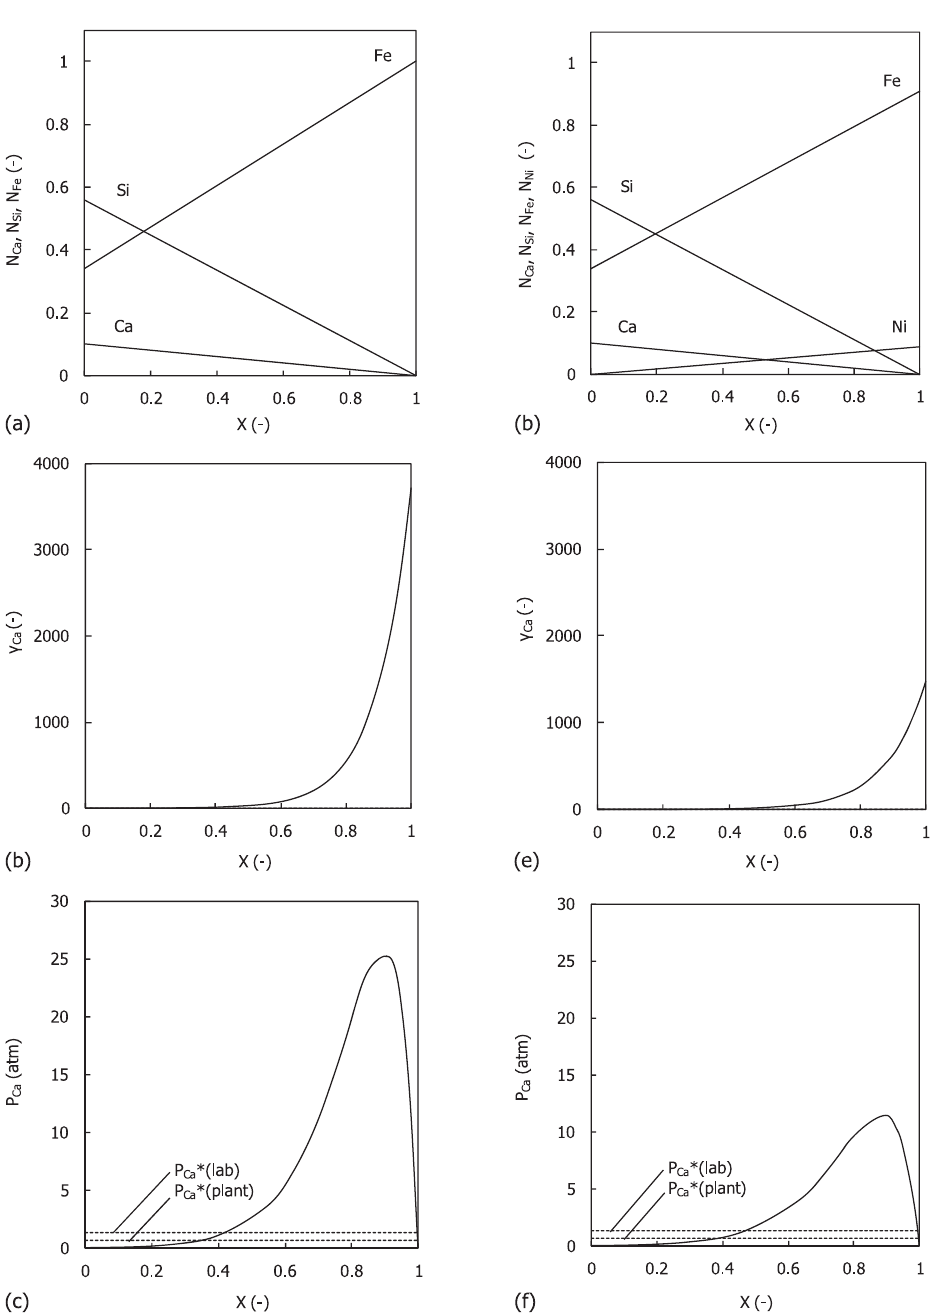
Fig. 6: Vapor pressure of calcium at the boundary layer region around the calcium alloy dissolving in the molten steel. (a)–(c) and (d)–(f) correspond to the case of the middle carbon steel and that of the nickel bearing steel,